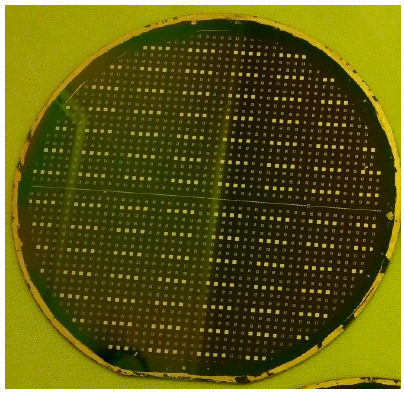
Figure 5. Photo of the MEMS inductor wafer.